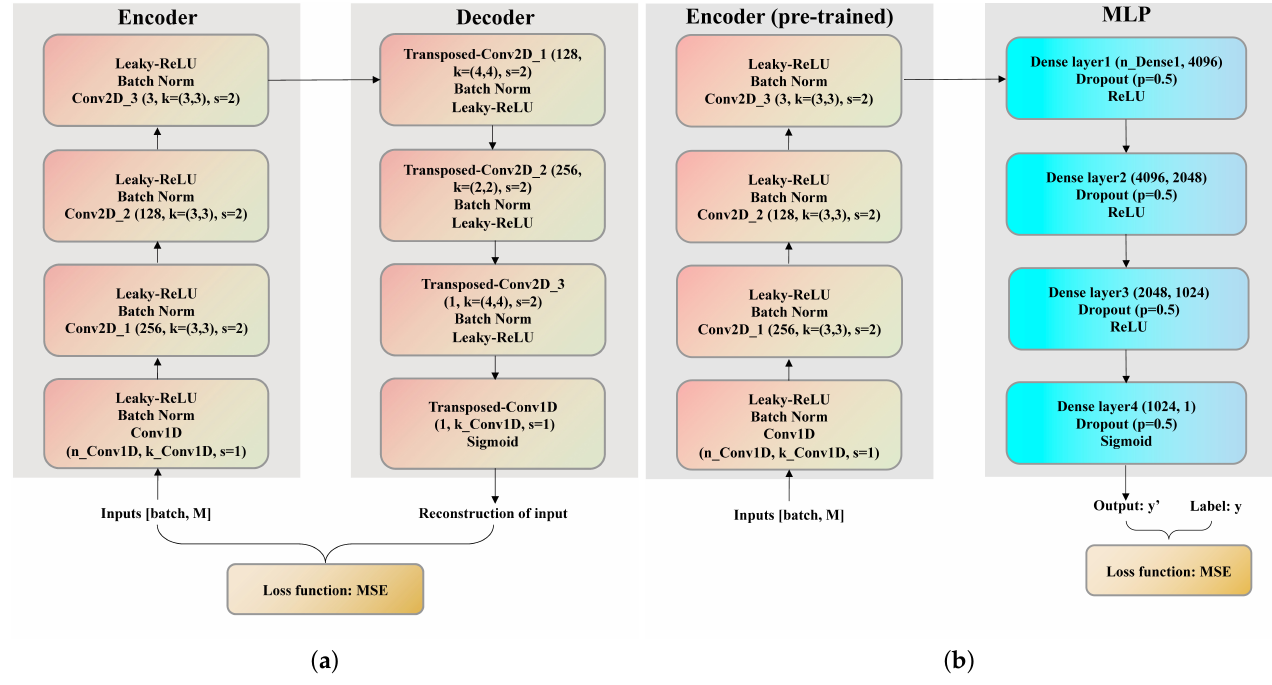
Figure 2. Design of our framework: ( a ) the convolutional autoencoder; ( b ) the Encoder-multi-layer perceptron (MLP)